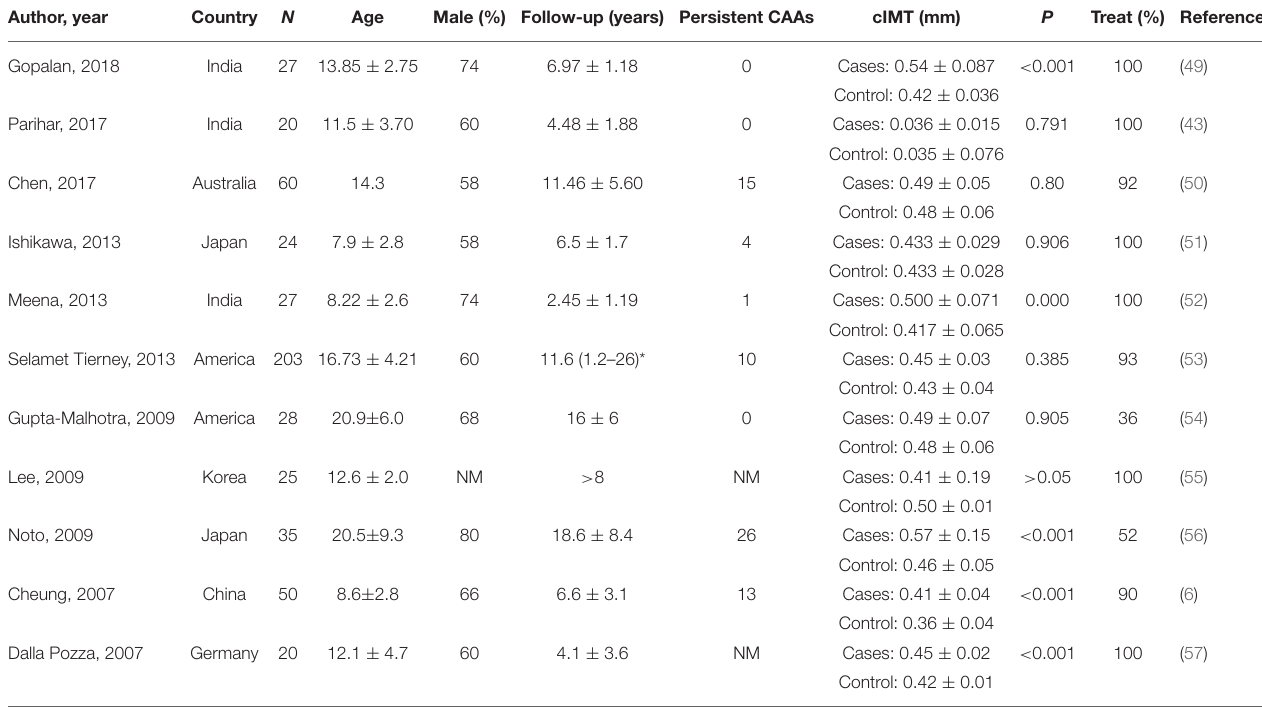
TABLE 1 | Studies on carotid intima-media thickness (cIMT) in patients with a history of KD. Author, year